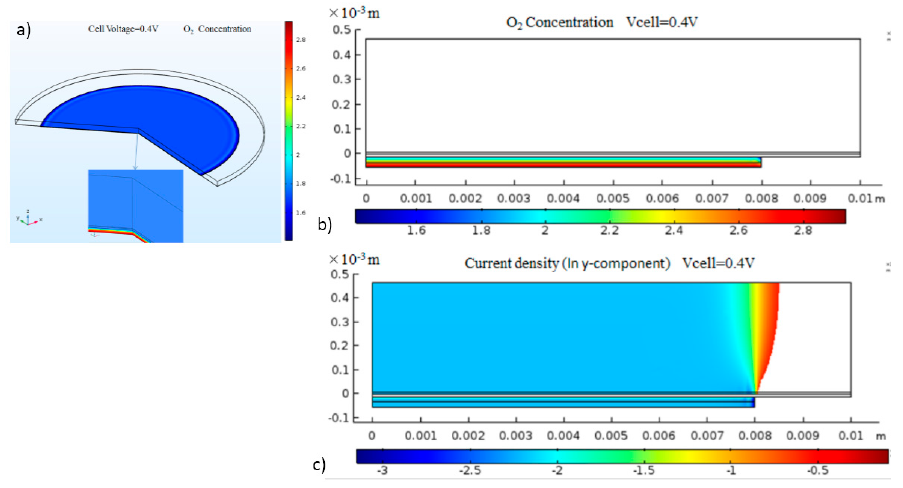
c distribution within porous cathode at T = 600 °C and V Figure 8. ( a , b ) Figure 8. ( a , b ) c O distribution within porous cathode at T = 600 ◦ C and V op = 0.4 V as an example; ( c ) 2 O 2 i e distribution throughout the whole button cell. i distribution throughout the whole button cell. ( c ) e